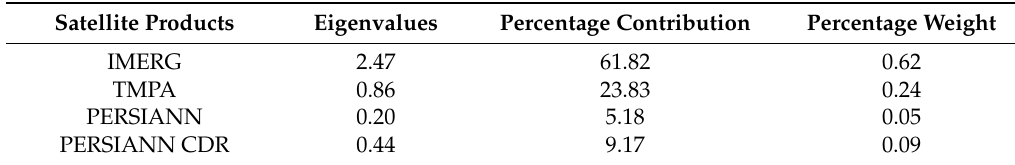
Table 5. Principal component analysis (PCA) of satellite products over the five climate